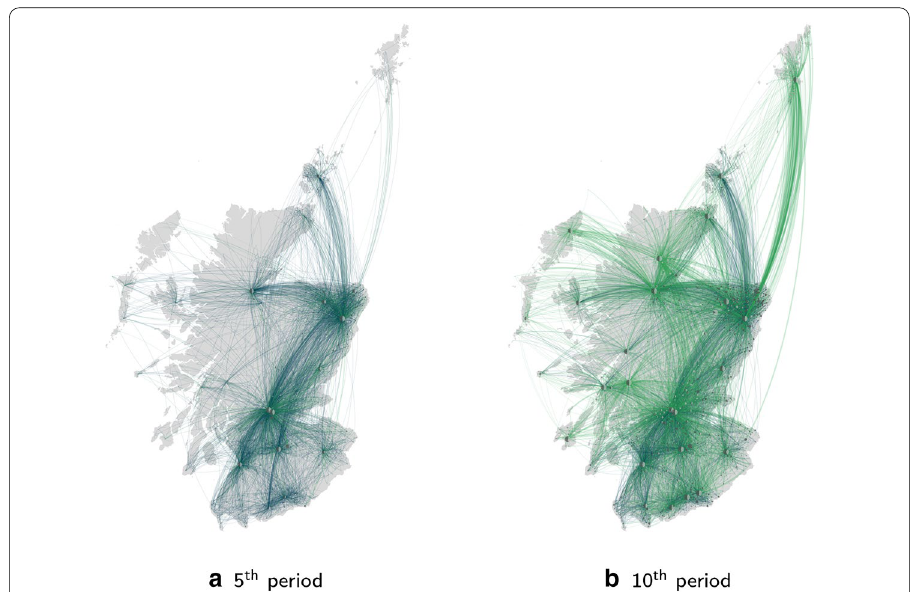
Fig. 2 Static network during the 5 th and 10 th periods of the year. Cattle movements are represented in blue, sheep movements in green. Nodes are represented by a pie chart where the light grey represents the proportion of outgoing movements, and the dark grey the proportion of ingoing movements. Built with Transmissio https ://www.gaelb n.com/trans missi o